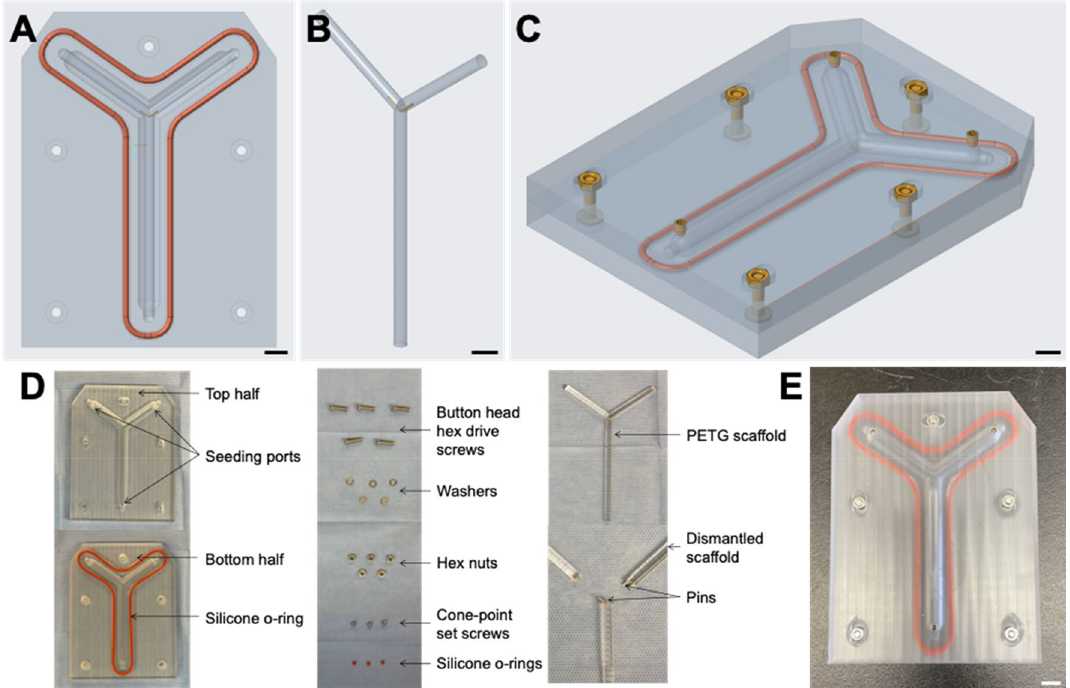
Figure 2. Custom made branched seeding chambers. ( A ) CAD of the system with CREO 5.0 software of the bottom half acrylic seeding chamber with Y-shaped indent and Y-shaped o-ring; ( B ) CAD of custom Y-shaped PETG scaffold with stainless-steel dowel pins; ( C ) CAD of the complete seeding chamber closed with hardware and view of small screws for seeding ports; ( D ) photograph of all the parts and hardware of the seeding chambers inside the biological hood on a sterile field; ( E ) photograph of the complete chamber closed with hardware and view of small screws for the seeding port. Scale bar = 1 ( P < 0.0001). In addition, more cells were counted in the supernatant after 4 h of seeding compared to any other time ( P < 0.0001) indicating that cells did not have the time to properly adhere to the scaffold and were still in the culture medium (Fig. 3C). Overall, the optimal cell seeding parameters were 0.15 M/mL cells at a speed of 90°/min for 22 h at 37 °C. Comparison between the novel spherical seeding method to other techniques. The novel spherical seeding technique was compared to a dynamic and a static seeding method. First, cell distribution on PETG scaffolds post-seeding can be observed with a Rhodanile Blue staining (Fig. 4A). Apparent uniform cell distributions can be observed on the mandrels using the spheric technique when compared to other seed- ing techniques (Fig. 4A and Supplementary Fig. 1). Furthermore, no statistically significant difference between spherical seeding and the other techniques was measured following proper counts of cells adhered to the scaf- folds after the 22-h seeding period (Fig. 4B). Remarkably, TEBV-A, produced using the described spherical system, were statistically ticker over TEBV-A produced using the other seeding techniques after a maturation period of 42 days of culture following initial seeding ( P < 0.05 and P < 0.0001) (Fig. 4C,D), indicating that a uni- form distribution may be important for the production of thicker TEBV-A. Another important aspect to consider here and to compare between different seeding methods is cellular viability. Therefore, flow cytometry live/dead assays were used to quantify cellular viability following the 22-h seeding (post-seeding) and 42 days maturation periods. Post-seeding viability was found to be significantly higher while using the spherical seeding system compared to other seeding methods; dynamic ( P < 0.001) and static ( P < 0.001) (Fig. 4E,F and Supplementary Fig. 2A). Although considerably lower, no difference in cell viability was measured, however, following the 42 days post-seeding maturation period in any of the tested seeding techniques (Fig. 4G,H and Supplementary Fig. 2B). The lower cellular viability measured in matured TEBV-A could simply be explained here by the 30-min enzymatic digestion needed to harvest the cells from the ECM for flow cytometry analysis; this step is not needed in post-seeding period. Overall, a more uniform cellular distribution, a thicker TEBV-A, as well as an enhanced cell viability were measured using the developed spherical rotary system when compared to other dynamic and static seeding techniques. Characterization of produced tissue‑engineered branched blood vessel— adventitia .